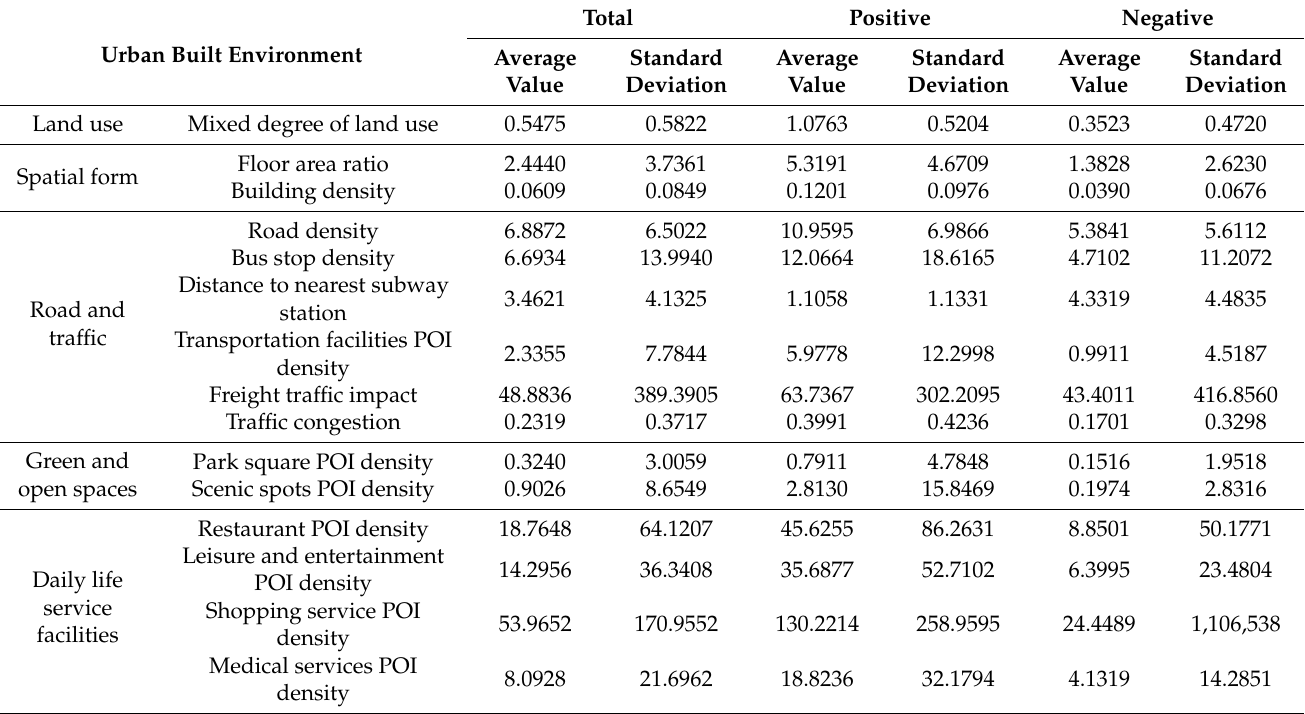
Table 7. Statistics of built environment element values under different emotional